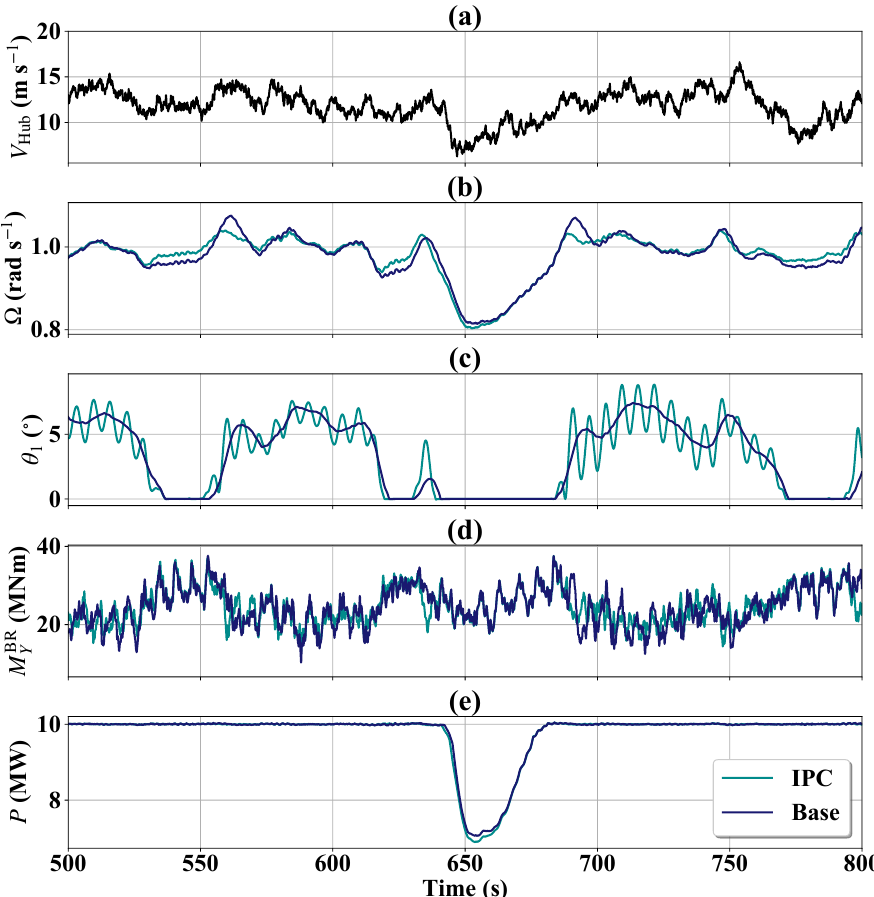
Figure 11. Time series selection of simulations with and without Individual Pitch Control (IPC) strategy from the 12 m/s wind speed bin. ( a ) Wind speed; ( b ) Rotor speed; ( c ) Blade 1 pitch angle; ( d ) Out-of-plane BRBM blade 1; ( e ) Generator power. Base = Collective Pitch Control (CPC)